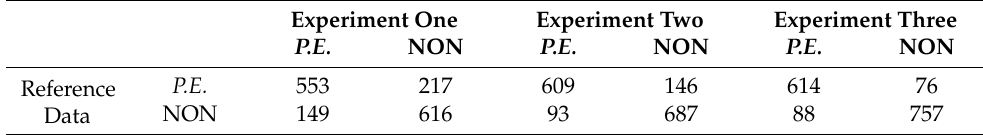
Table 3. Confusion matrix for experiment one, experiment two, and experiment three. P.E. , P. euphratica ; NON, non- P. euphratica .